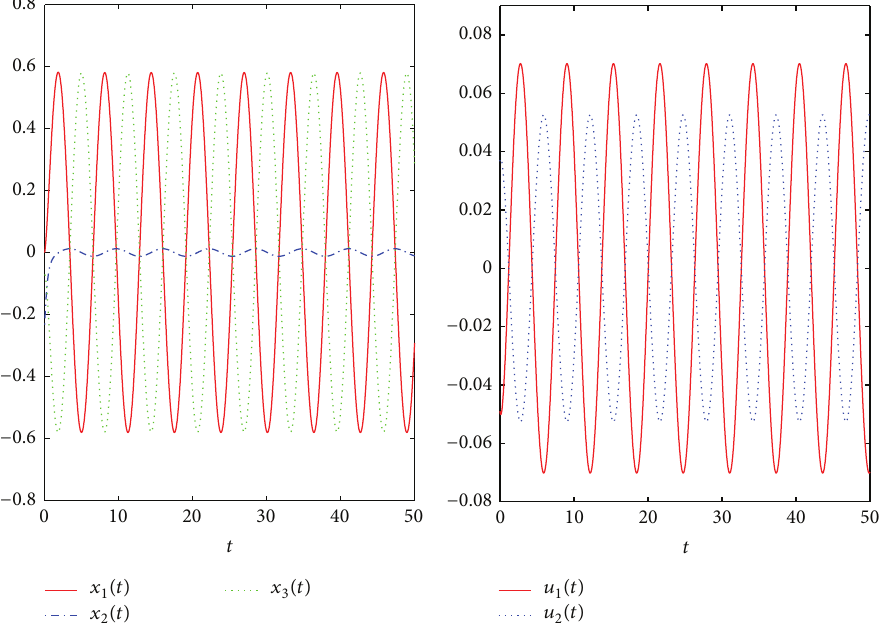
Figure 2: Curves of the state and control variables when exosystem is not asymptotically